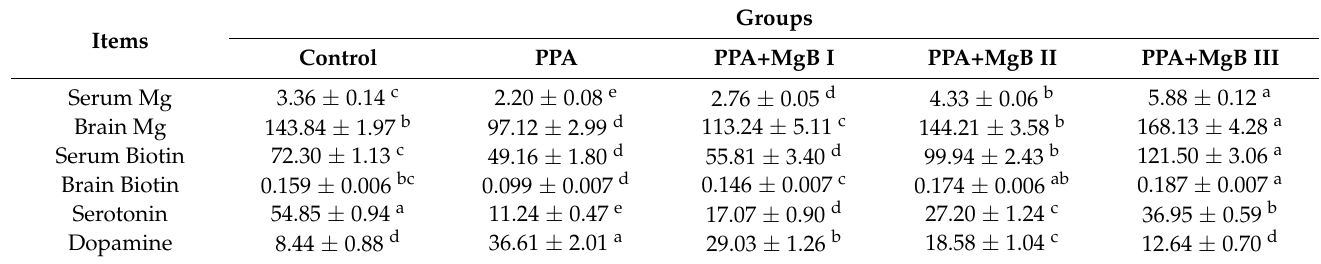
Table 1. Effects of magnesium biotinate (MgB) supplementation on magnesium (mg/dL or µ g/g), biotin (nmol/L or nmol/g), brain serotonin (ng/g), and dopamine (ng/g) concentrations in propionic acid (PPA) induced autism in rats.